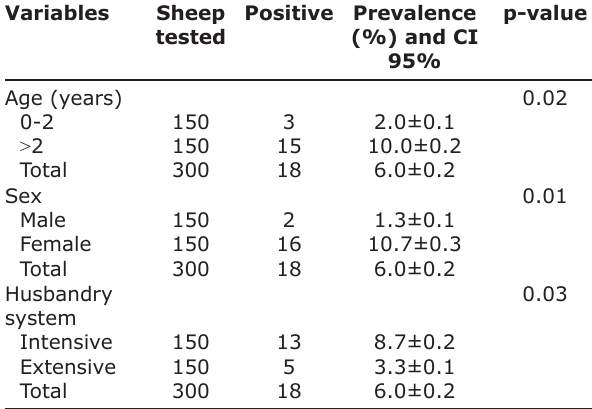
Table-3: Seroprevalence of brucellosis by age, sex, and breeding system of sheep collected in the Province of Bam in Burkina Faso,